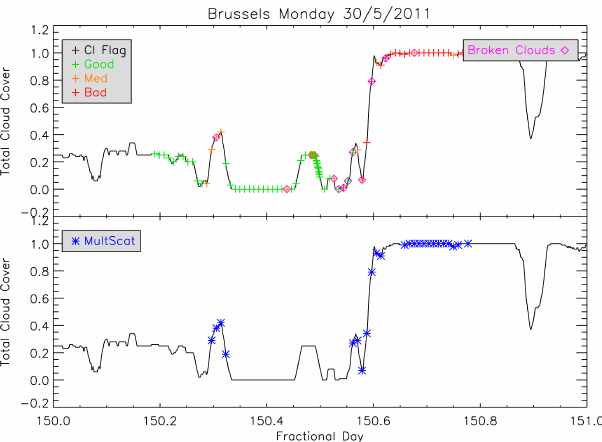
Figure 11. Top: distribution of the cloud-cover percentages for the full Brussels data set in black, with the division of data points with different sky flags. In red we plot data with a “bad” sky flag, in orange data with a “good/med” sky flag and a broken-cloud flag, and green denotes points with a “good/med” sky flag but no broken- cloud flag. In blue we mark data with a multiple-scattering flag. Bottom: fraction of total cloud-cover values as distributed over our different flag